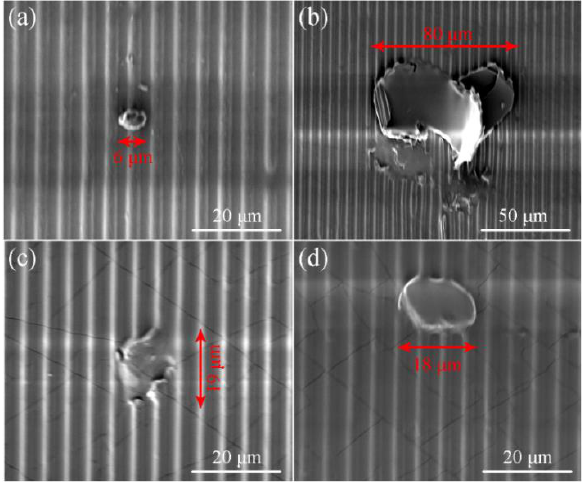
Figure 2. ( a ) Scanning electron microscopy (SEM) images of the mould with adheredparticle. SEM images of the grating patterns under the imprint pressure of ( b ) 50, ( c ) 150 and ( d ) 200 kPa when the particles radius of 4 μm.